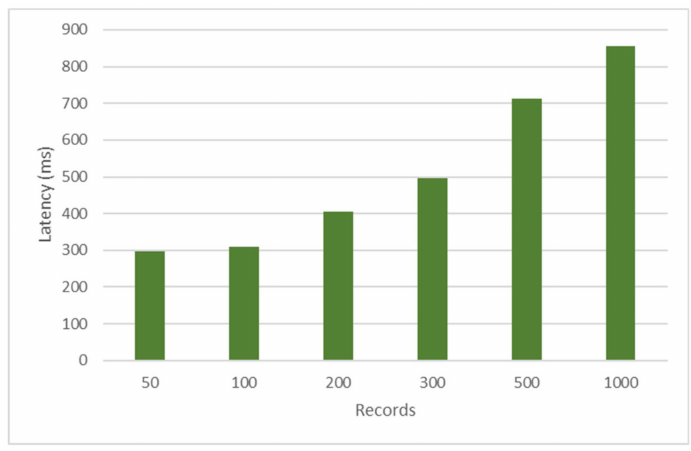
Figure 17. Synchronizer resilience time.